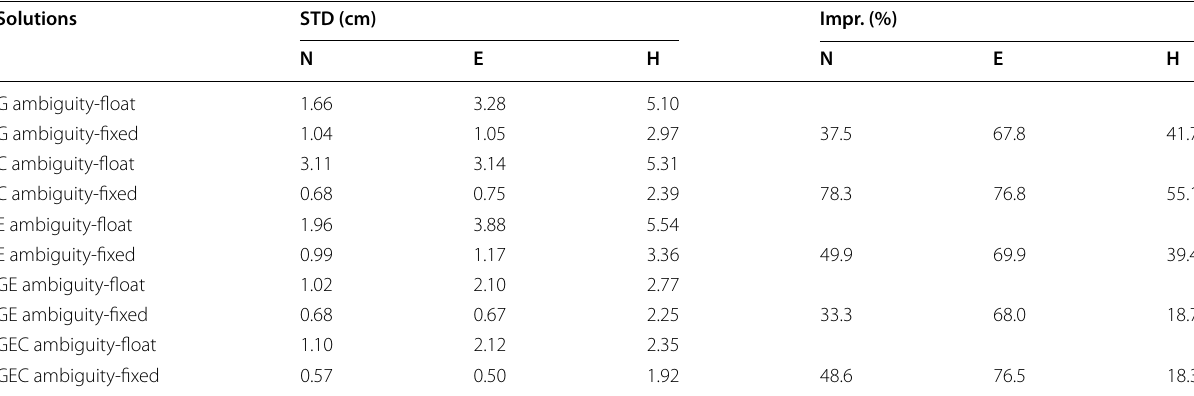
Fig. 8 Galileo only PPP (top) and PPP-IAR (bottom) solutions for North (blue), East (green) and Height (red) components